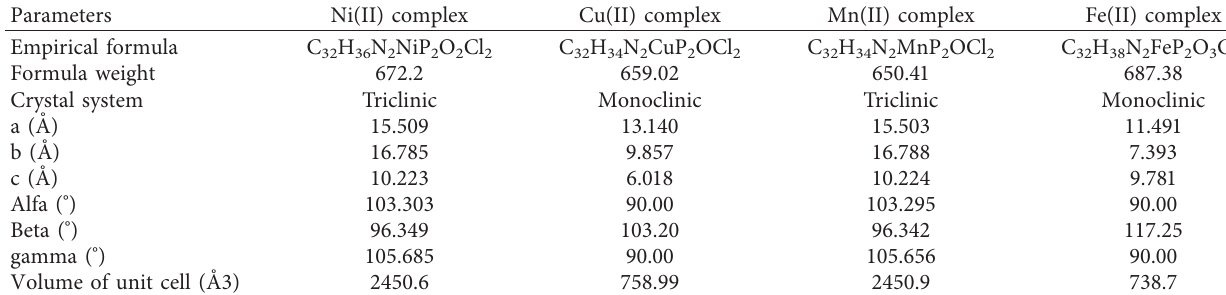
Table 7: X-ray powder diffraction crystal data of